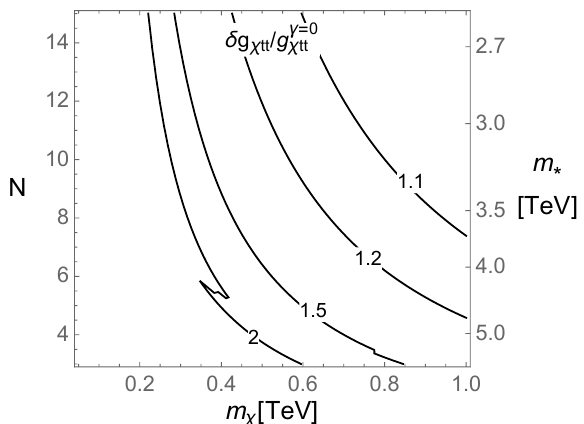
Figure 13 . Strength of the dilaton-top coupling (7.4) in the benchmark model with a varying top mixing, normalized to the analogous strength for a constant top mixing. For the thus de(cid:12)ned relative strength the di(cid:11)erence between the glueball and meson dilaton is